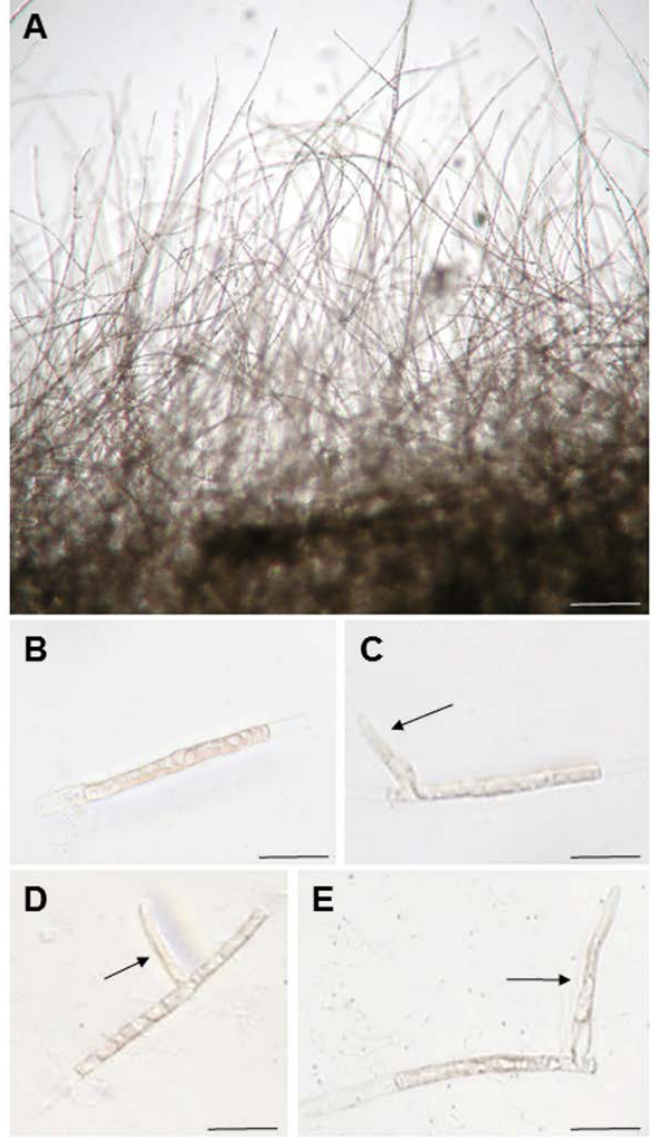
Figure 1. Generation of tip-growing side branches from single-celled conchocelis filaments. ( A ) Conchocelis filaments maintained in the laboratory; ( B ) a single-celled conchocelis; ( C – E ) side branches produced at various positions on single-celled conchocelis. Arrows indicate side branches. Scale bars: 100 μm in ( A ); 25 μm in ( B – E ).